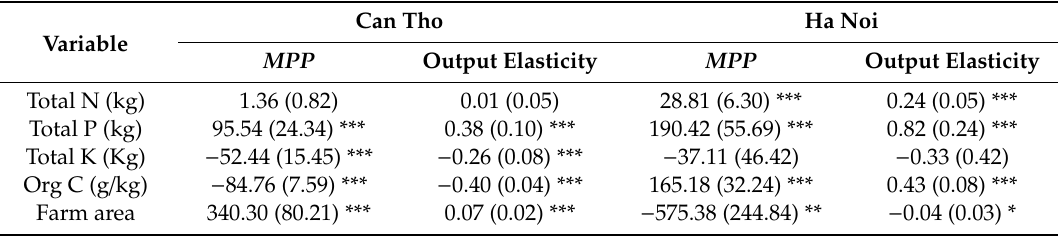
Table 9. Marginal physical product ( MPP ) and output elasticity at the mean level in Vietnam. Can Tho Variable